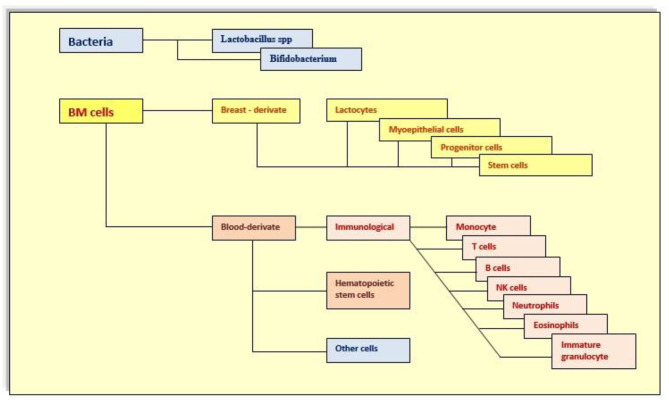
Cells in human milk.